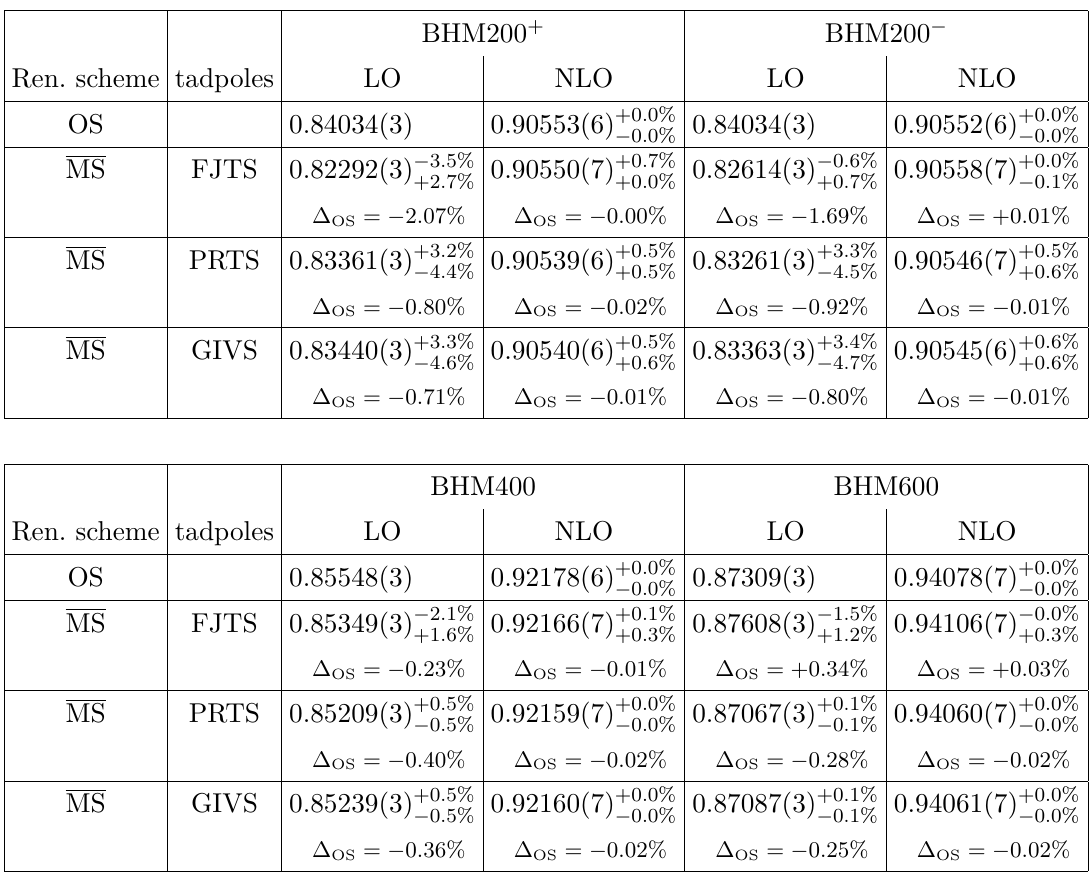
Table 1 . LO and NLO decay widths Γ h → 4 f [MeV] of the light SESM Higgs boson h for various SESM scenarios in different renormalization schemes, with the OS scheme as input scheme (and full conversion of the input parameters into the other schemes). The scale variation (given in percent as sub- and superscripts) corresponds to the scales µ = µ 0 / 2 and µ = 2 µ 0 with central scale µ 0 = M h . The quantity ∆ OS = Γ / Γ OS − 1 shows the relative difference between the MS predictions and MS the OS value; its spread illustrates the scheme dependence of the prediction at LO and